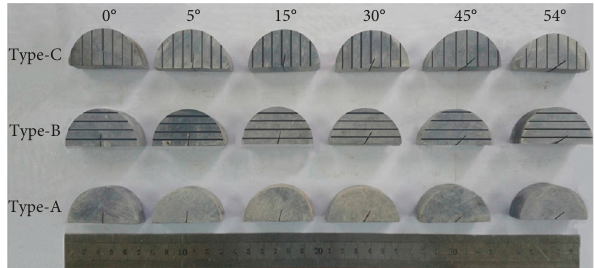
Figure 4: Three types of SCB specimens for different crack angles. Table 1: Fracture parameters ( Y T ∗ ) for the SCB specimens I , Y II , with ( α / R � 0.35 and S / R � 0.50) and for various crack inclination angles (according to Ayatollahi and Aliha